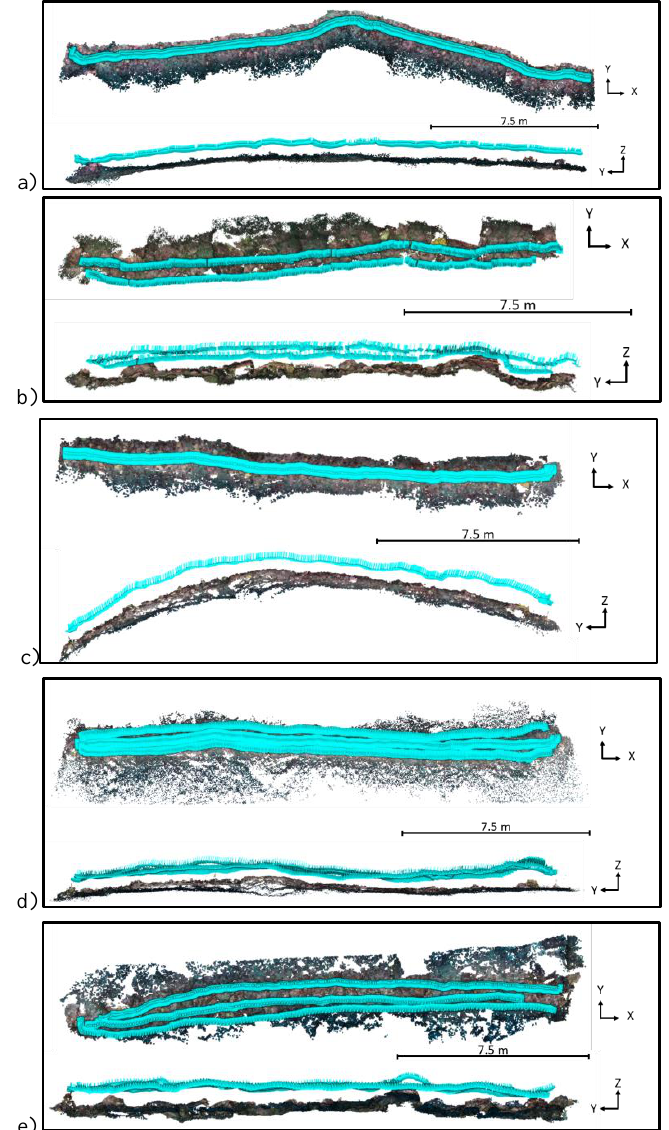
Figure 3. Camera network of the different video processed: a) S1-2006, b) T2-2015, c) T1-2017 with only nadir looking images, d) T1-2017 with nadir and oblique looking images, e) T2-2017. The image positions are shown in